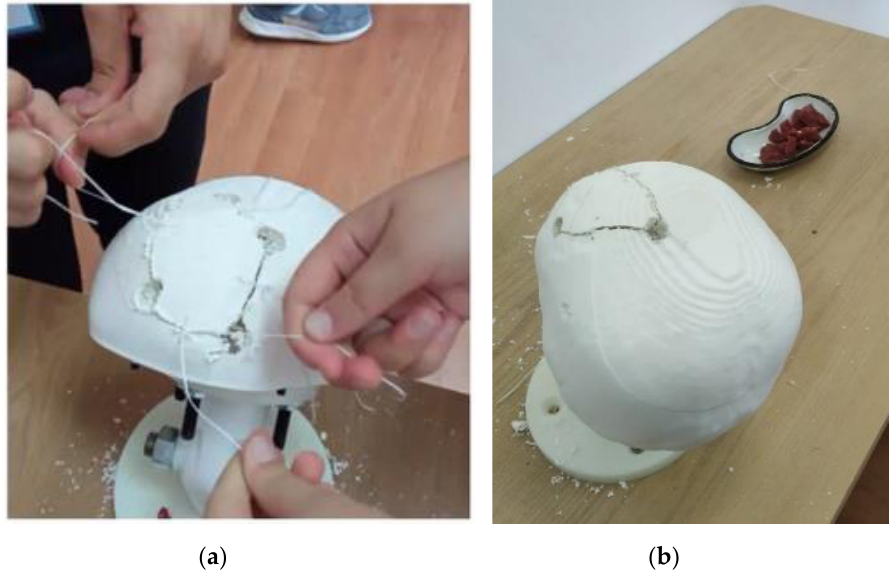
Figure 11. Final suture of the skull ( a ) with the tumor removed ( b